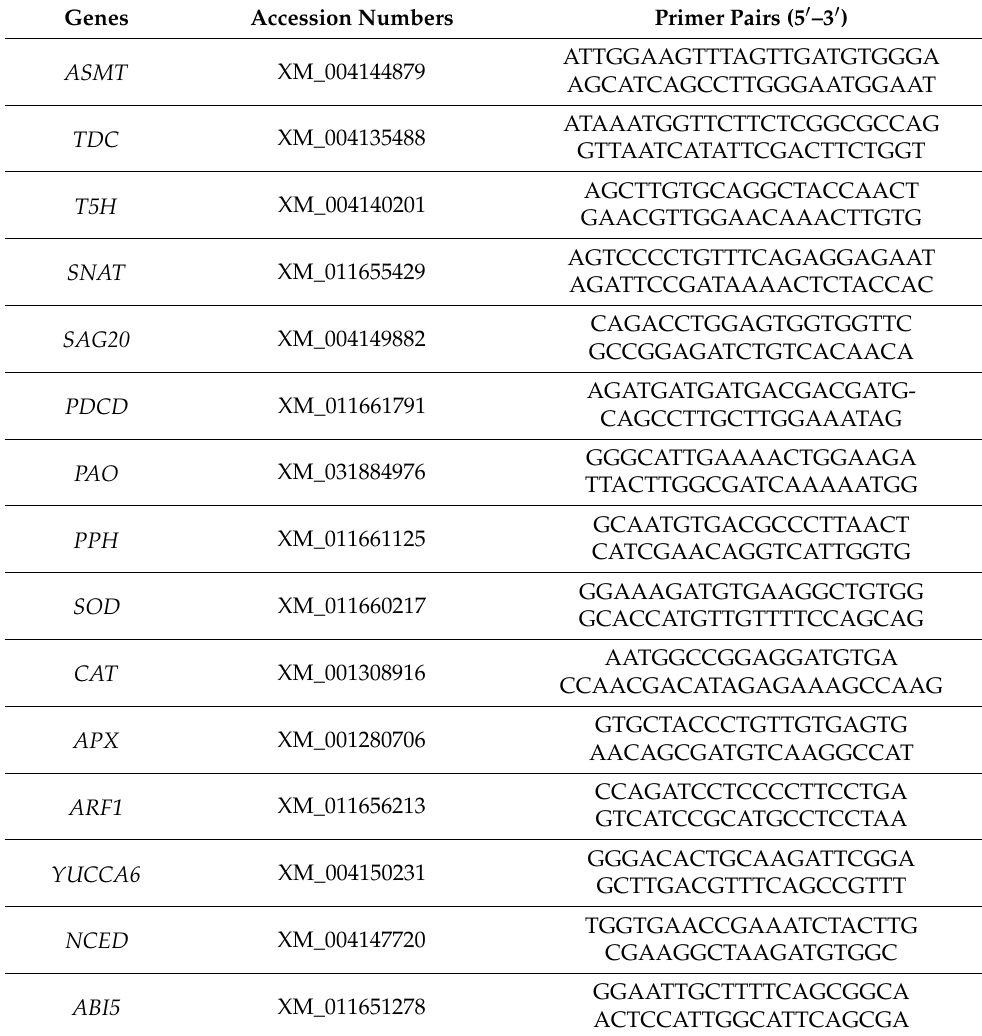
Table 1. The primers for RT-PCR.